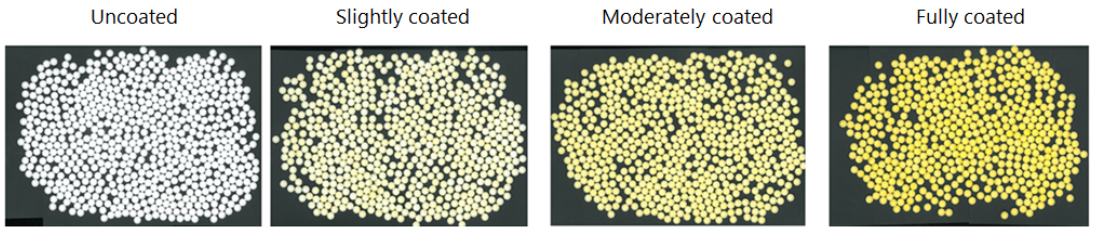
Figure 1. The four different batches with an increasing amount of coating solution.